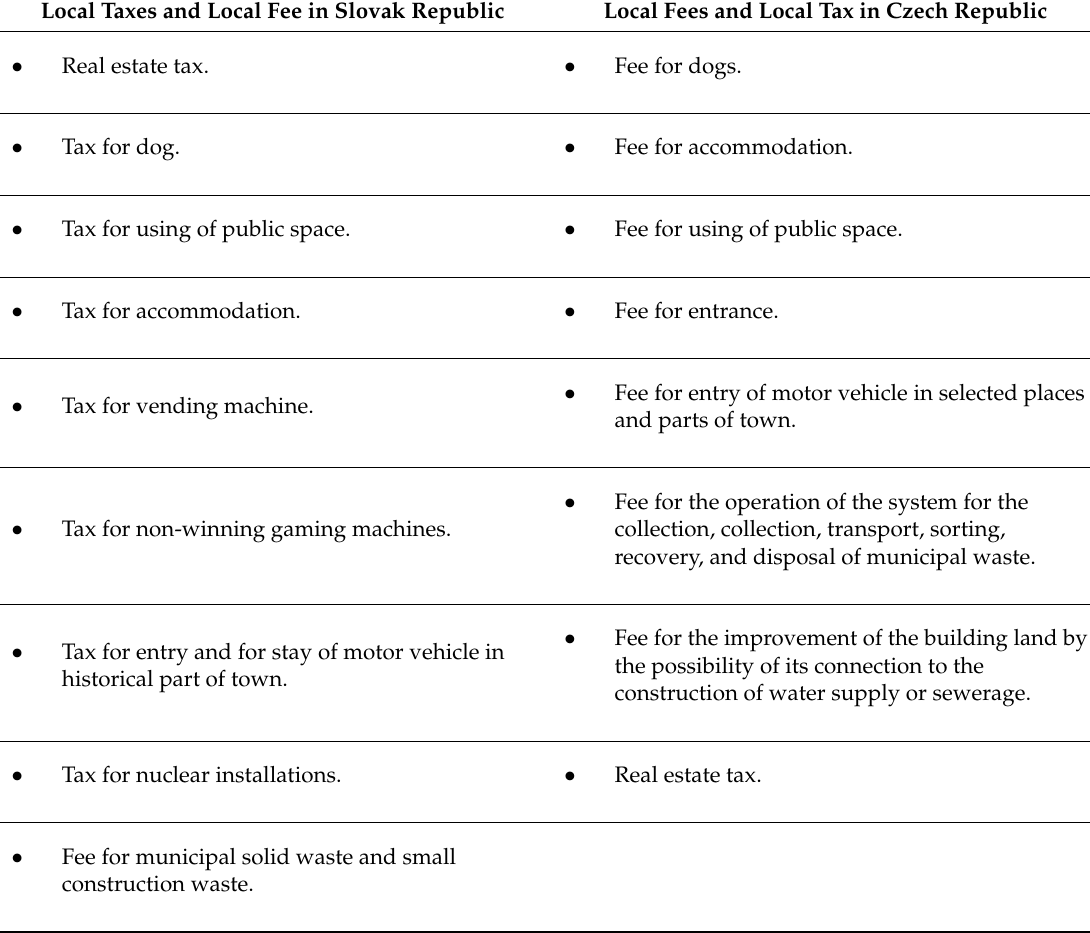
Table 4. The structure of local fees of municipalities in Slovak Republic and in Czech